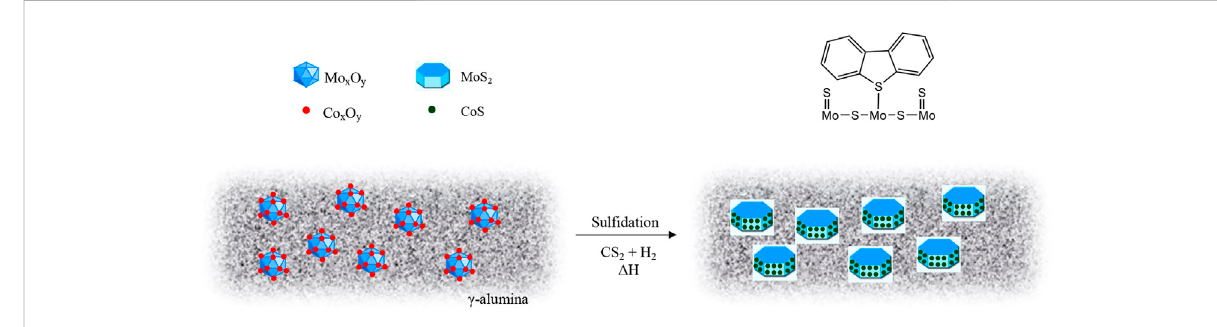
FIGURE 3 Schematic of the sul fi dation process for CoMo catalyst showing DBT binding on a coordinatively unsaturated Mo site (Moqadam and Mahmoudi,